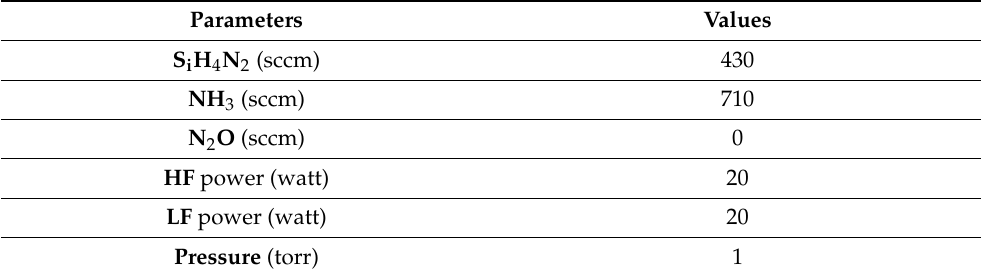
Table 1. Parameters of the PECVD process for the S i O 2